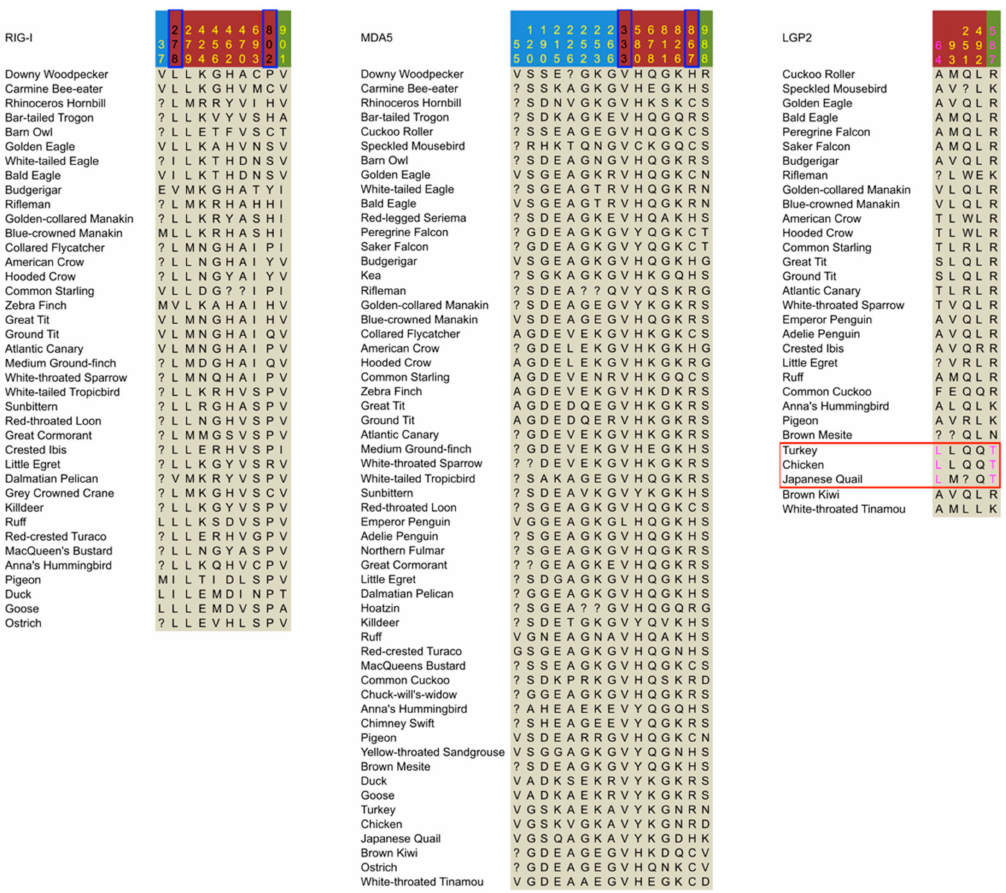
Figure 2. Summary of positively selected sites identified in the three avian RIG-I-like receptors. Colors of site numbers indicate the type of positively selected sites (PSSs): yellow corresponds to pervasive positively selected sites (PPSSs), magenta corresponds to the episodic positively selected sites (EPSSs) showing specific substitutions in the LGP2 of Galliformes, and black corresponds to other EPSSs. The LGP2 of Galliformes is indicated by a red rectangular frame. The blue frames on the site numbers indicate PSSs located identically in RIG-I and MDA5. Site numbers are according to chicken sequences for MDA5 and LGP2, and the goose sequence for RIG-I. Background colors of site numbers represent coding sequence (CDS) regions defined for convenience in this paper: sky blue for the caspase recruitment domains (CARDs) region, dark red for the helicase region, and green for the C-terminal domain (CTD)